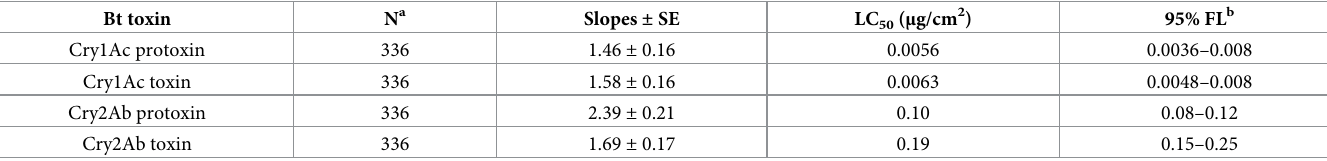
Table 1. Toxicity of Cry1Ac and Cry2Ab protoxins and their respective midgut juice-digested toxins against neonates of the susceptible SCD strain of H . armigera . Bt